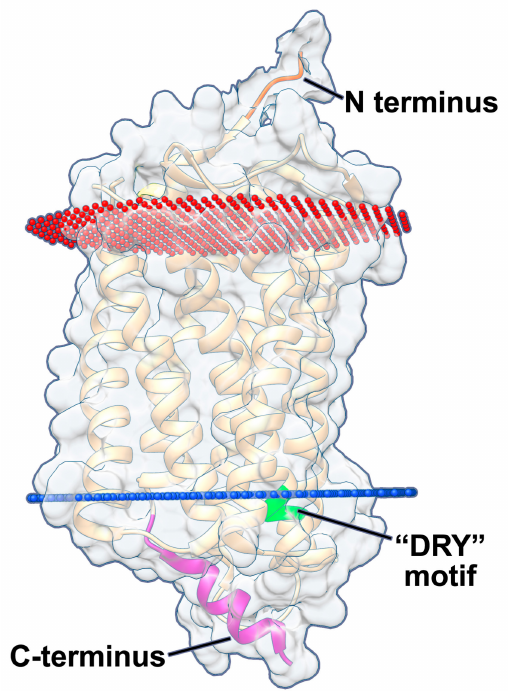
Figure 1. HCMV pUS28 structure. The viral GPCR, pUS28 contains seven transmembrane spanning helices (beige). The N-terminus (orange) of the protein is extracellular and required for ligand binding, while the C-terminal domain (purple) is intracellular and important for protein trafficking. The Y16F ligand binding domain mutant is a single amino acid point mutation at position 16 found within the N-terminus (orange). The canonical “DRY” motif (green) is located within the second intracellular loop and is required for G-protein coupling. The R129A and R129Q mutants discussed herein mutate the arginine (R) of the “DRY” motif to an alanine (A) or glutamine (Q), which ablates G-protein coupling. Extracellular membrane, red; intracellular membrane, blue. The structure is based on the pUS28 crystal structure, bound to CX 3 CL1 ([34]; PDB ID: 4XT3), using Chimera [35] and the Orientations of Proteins in Membranes (OPM) databases